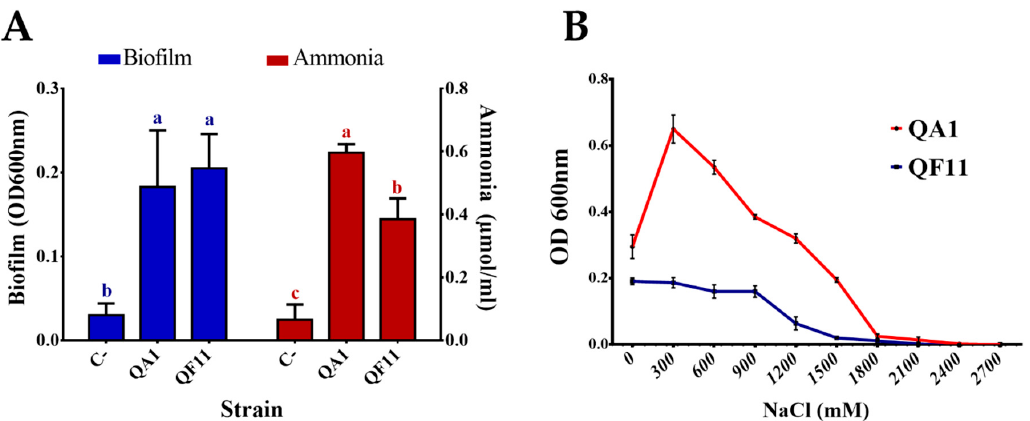
Figure 2. ( A ) Biofilm and ammonia production by selected PSB isolates. ( B ) Effect of NaCl on selected PSB strains after 48 h of incubation in TSB broth. The values represent means of replicates ( n = 3) ± standard deviations. Uninoculated media were used as a negative control (C-). The different letters in superscript (a, b, c…) indicate the statistically significant difference at 95% between treatments. Table 2. Summary of relevant phenotypic traits observed with selected PSB strains using plate assay. Bacterial